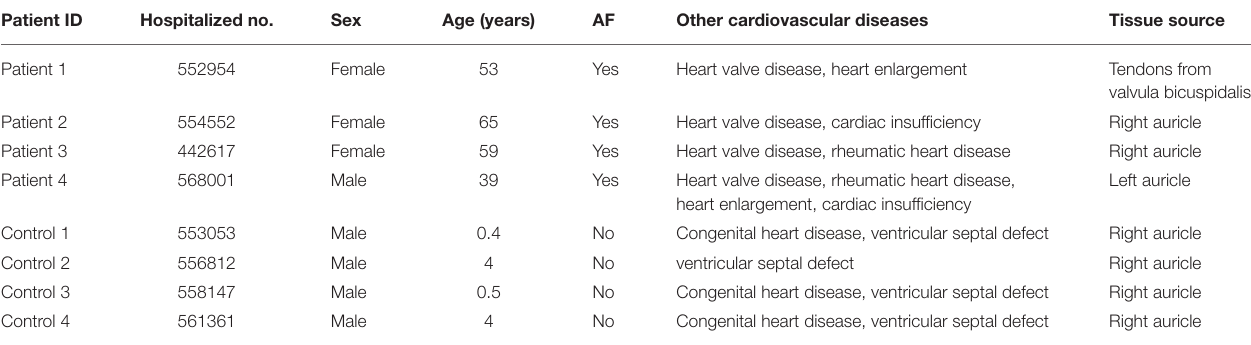
TABLE 3 | Clinical information of subjects for fluorescence in situ hybridization (FISH). Patient